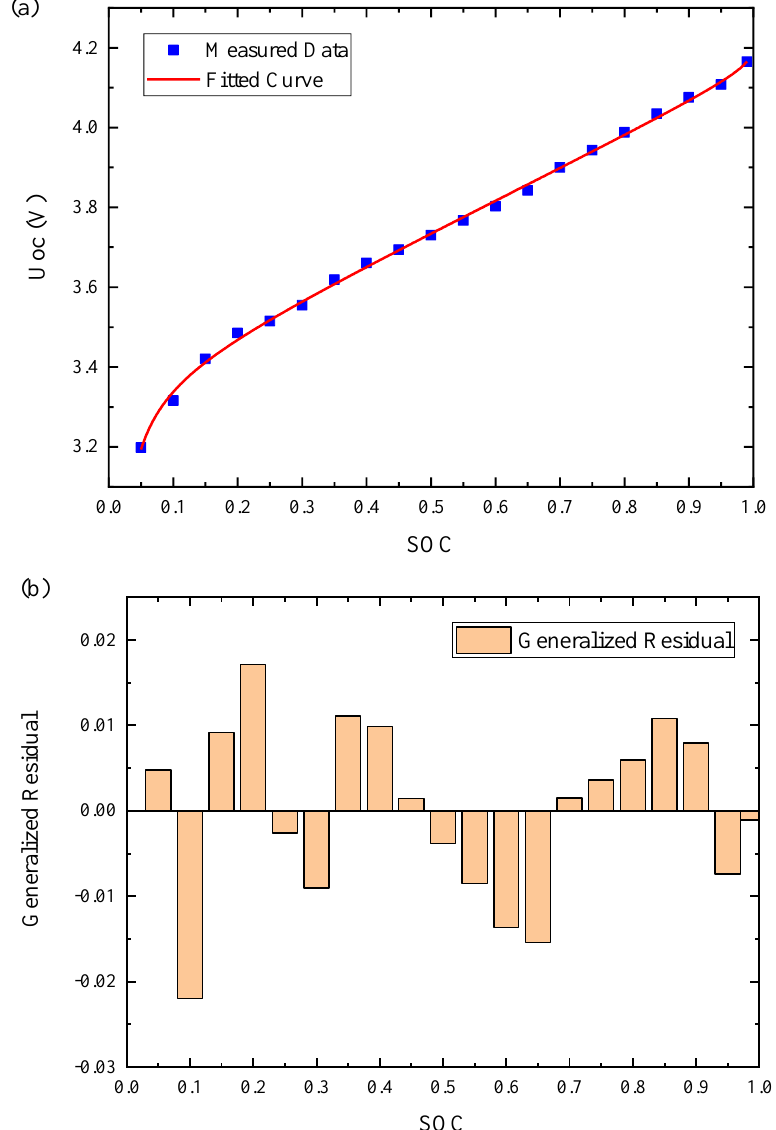
Figure 6. The OCV result at temperature of 0 °C: ( a ) fitting curve; ( b ) the generalized residual. To further improve the model accuracy, the OCV was corrected by ℎ 𝑣 ; the ℎ 𝑣 is preprocessed to form an offline ℎ 𝑣 -SOC-T look-up table. As shown in Figure 7, the OCV boundaries of discharge and charge process and hysteresis level under various temperatures were depicted.